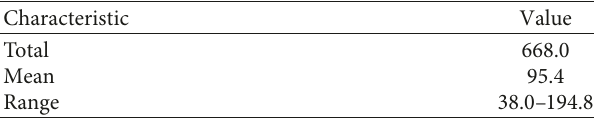
Table 3: Characteristics of video footage ( n �